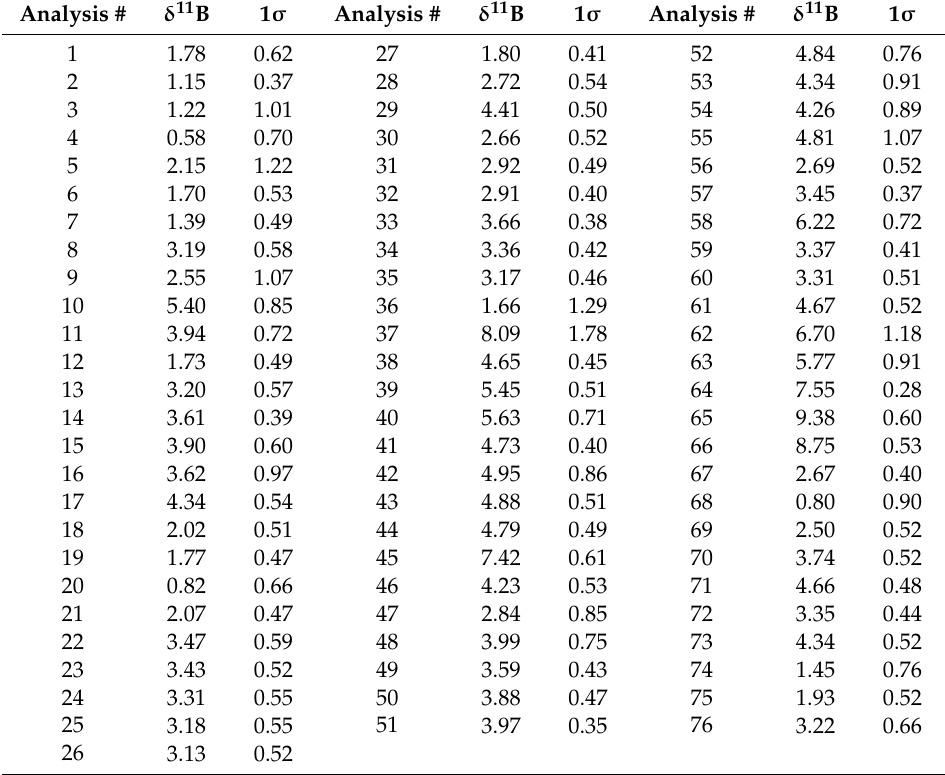
Table 6. B isotope compositions for tourmaline